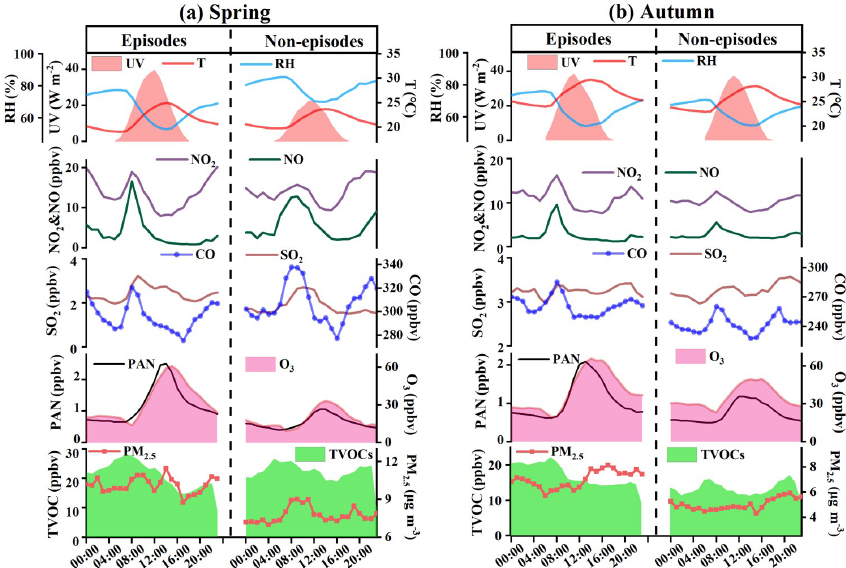
Figure 4. Diurnal trends of PAN, O 3 , TVOCs, PM 2 . 5 , other trace gases, and meteorological parameters during episodes and non-episodes in (a) spring and (b) autumn,